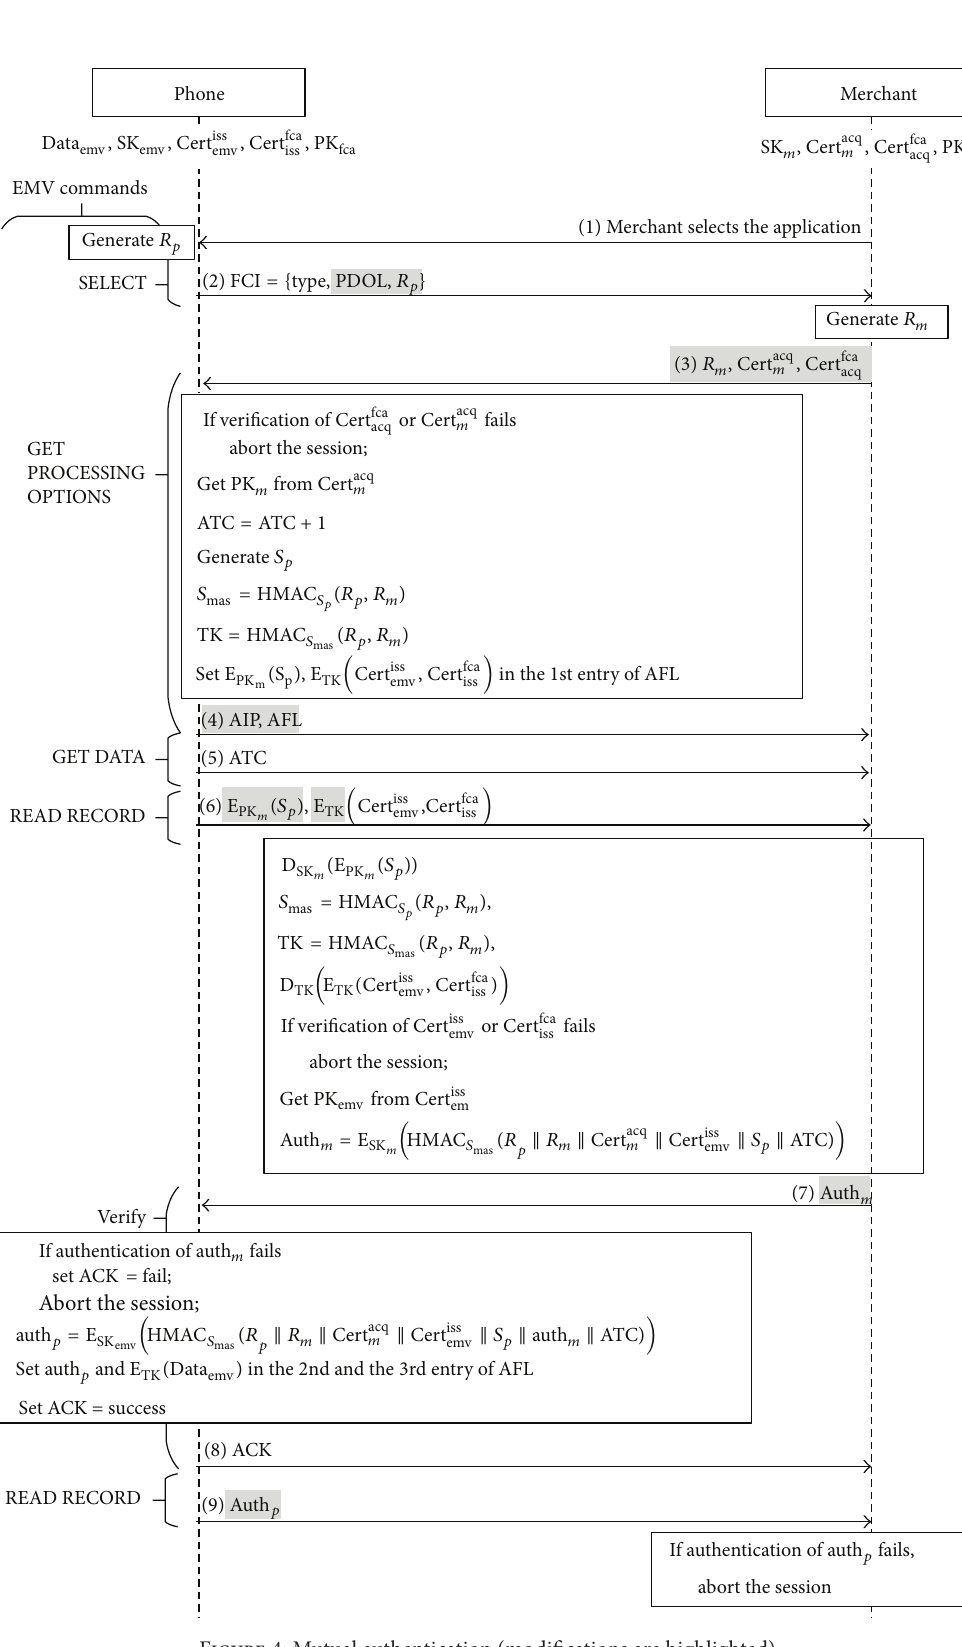
Figure 4: Mutual authentication (modifications are